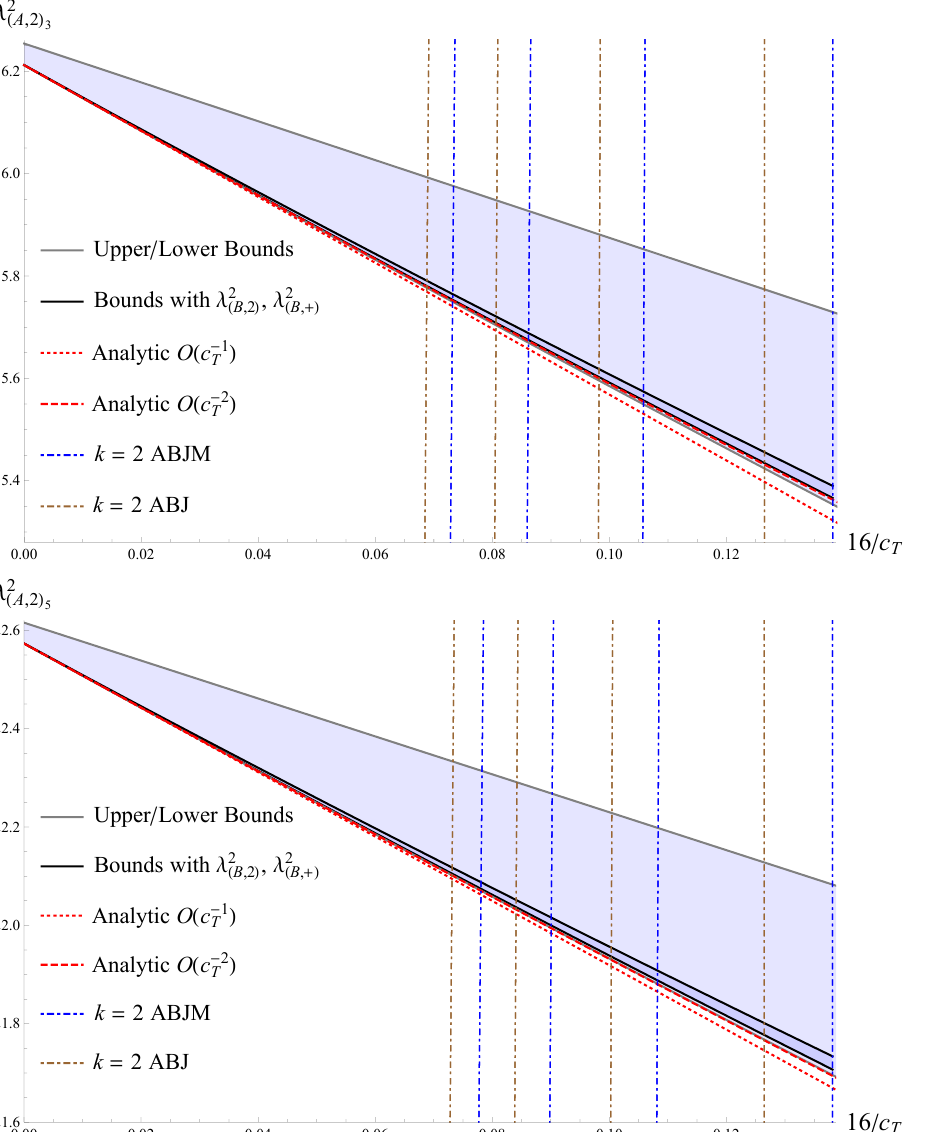
OPE coefficient for ‘ = 3 (top) and ‘ = 5 ( A, 2) ‘ and λ 2 for k = 2 ABJ(M) inputed into the ( B, +) ( B, 2) ) , which is independent of k . The red dashed T ) , which depends on the value k = 2 , T ) . The blue and brown vertical T